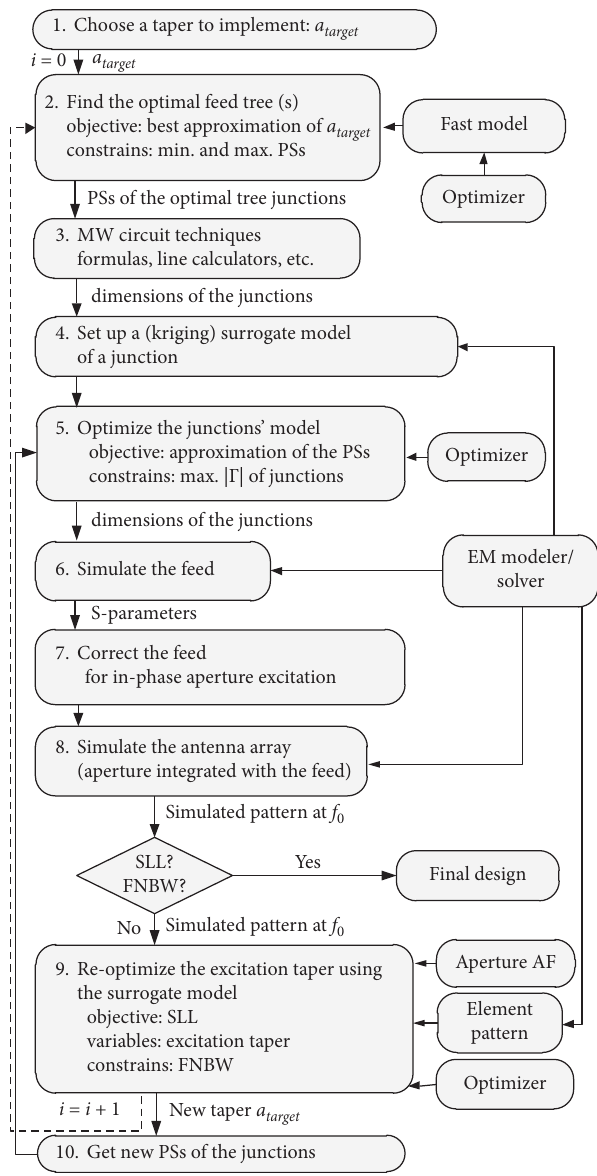
Figure 7: Process diagram of a surrogate-assisted design of low- sidelobe linear arrays inclusive of corporate feeding network [53]. PS stands for the feed junction split ratio, | Γ | denotes the general reflection coefficient at the junction input, a stands for the exci- tation taper, and f 0 is the working frequency. The AF is used at Steps 2 and 9. A more general realization of the design process can search for and implement a new optimal architecture after Step